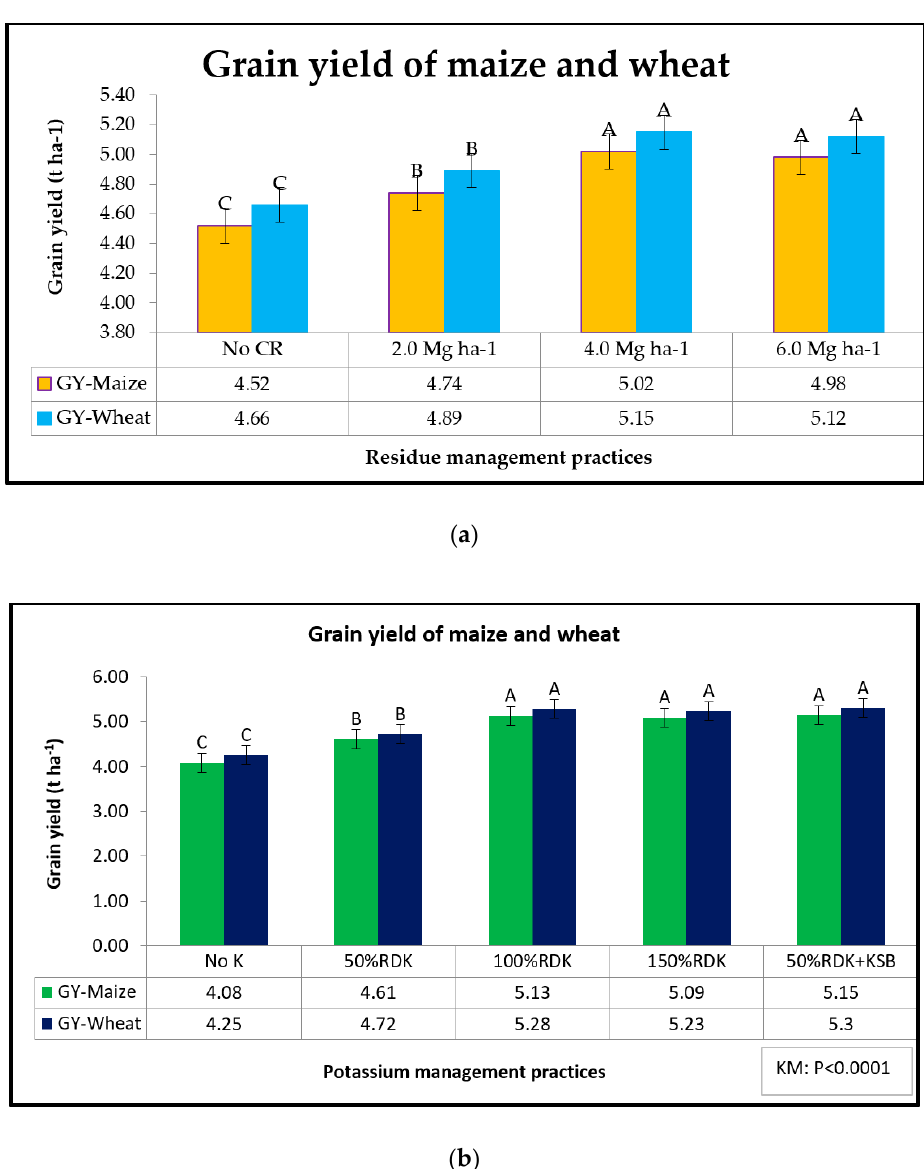
Figure 2. ( a ) Crop residue management on grain yield of maize and wheat under zero tillage maize–wheat system (pooled data of two years), GY: grain yield, CR: p < 0.0001; ( b ) Potassium management on grain yield of maize and wheat under zero tillage maize–wheat system (pooled data of two years), GY: grain yield.